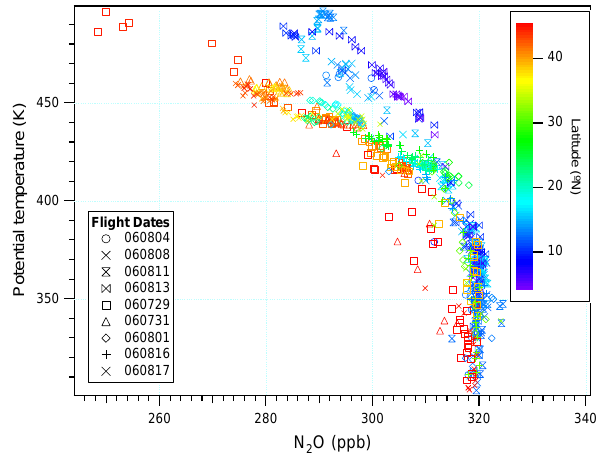
Fig. 6. CO profiles for 7 and 8 August. The black lines represent the two most extreme possible mixing lines that could explain the high CO values at 410K. One mixing line would mean mixing of air parcels with a potential temperature of 355K and 430K, the other line mixing of air parcels with potential temperatures of 355K and 470K. Any mixing line in between these two extremes is possible to explain the enhanced CO values at 410K.